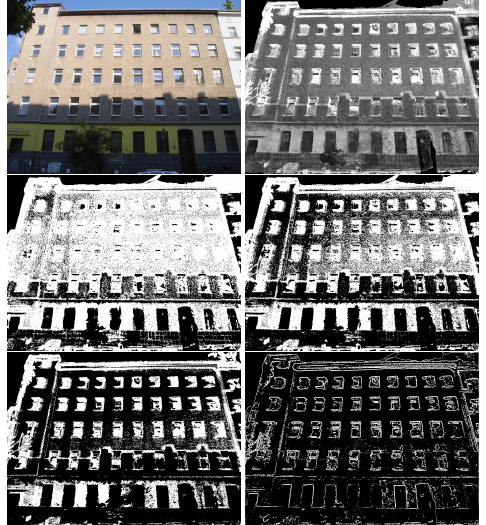
Figure 11. From top left to bottom right: fac¸ade image, visual- ization of colour differences to complete sequence, segmentation of colour difference image using the 0 . 3 , 0 . 5 and 0 . 7 quantiles of pixels unequal 0 , image with gradient